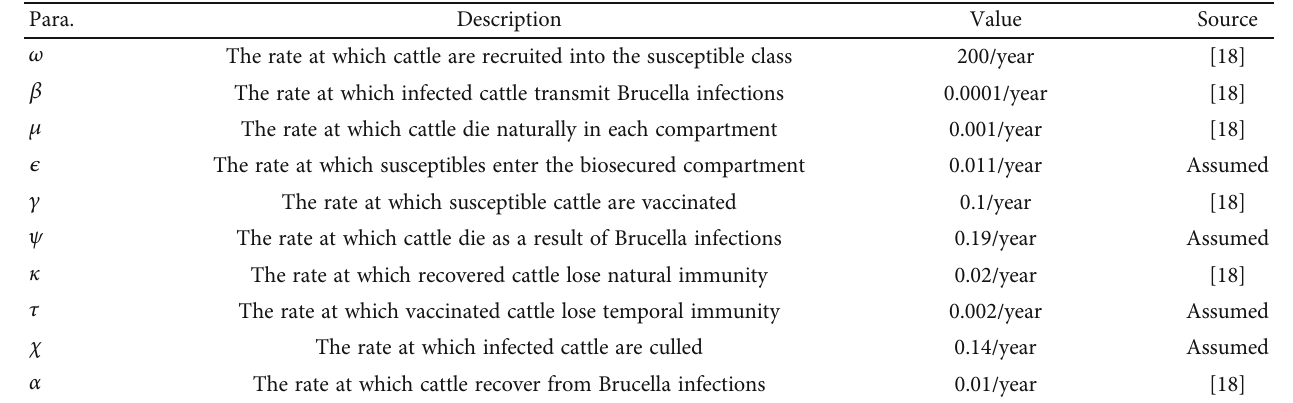
Table 3: The parameter